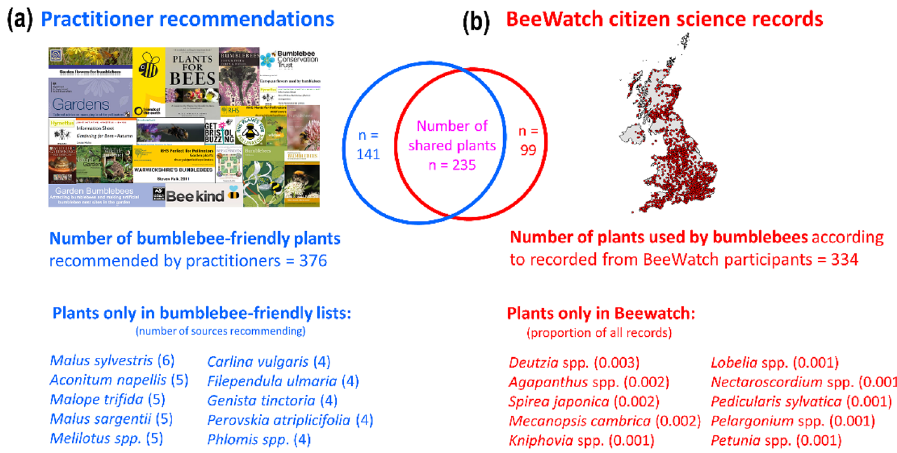
Figure 2. Comparison of data sources: practitioner recommendations versus BeeWatch citizen science data. Images of practitioner sources used for gathering data on pollinator and bumblebee friendly plants and a map of the UK showing all locations for which BeeWatch data were submitted, and schematic showing numbers of plants recommended as bumblebee-friendly by practitioners and number of plants photographed and reported by BeeWatch participants as being used by UK bumblebees (middle). (a) Practitioner sources used for gathering data on pollinator- and bumblebee-friendly plants and the total number of plants recommended as bumblebee- friendly (in blue; derived from 14 sources detailed in Suppl. Appendix Table 1 in bold font); (b) red symbols show locations of observations of bumblebees feeding on plants across the UK as recorded and photographed by BeeWatch participants between August 2011 and June 2017 and the total number of plants recorded and photographed as being used by UK bumblebees by BeeWatch participants (in red). The number of plants common to both the bumblebee-friendly list and BeeWatch is shown in purple. The top 10 plants recorded in BeeWatch but not found in the bumblebee-friendly list shown in red (number in brackets = their proportions out of the total number of plants recorded). The top 10 plants reported as being good for bumblebees but not recorded by BeeWatch participants shown in blue, number in brackets = number of sources they occurred in, from a total of 14). The UK map contains data from BeeWatch (2011–2017) and OS data Crown copyright and database right (2019) and was generated by H. Anderson using ArcGIS Desktop 10.7 Esri Inc.